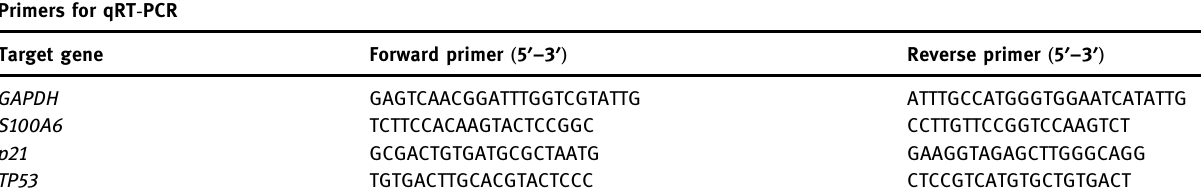
Table 1: Sequences of the primers used in qRT - PCR Primers for qRT - PCR Target